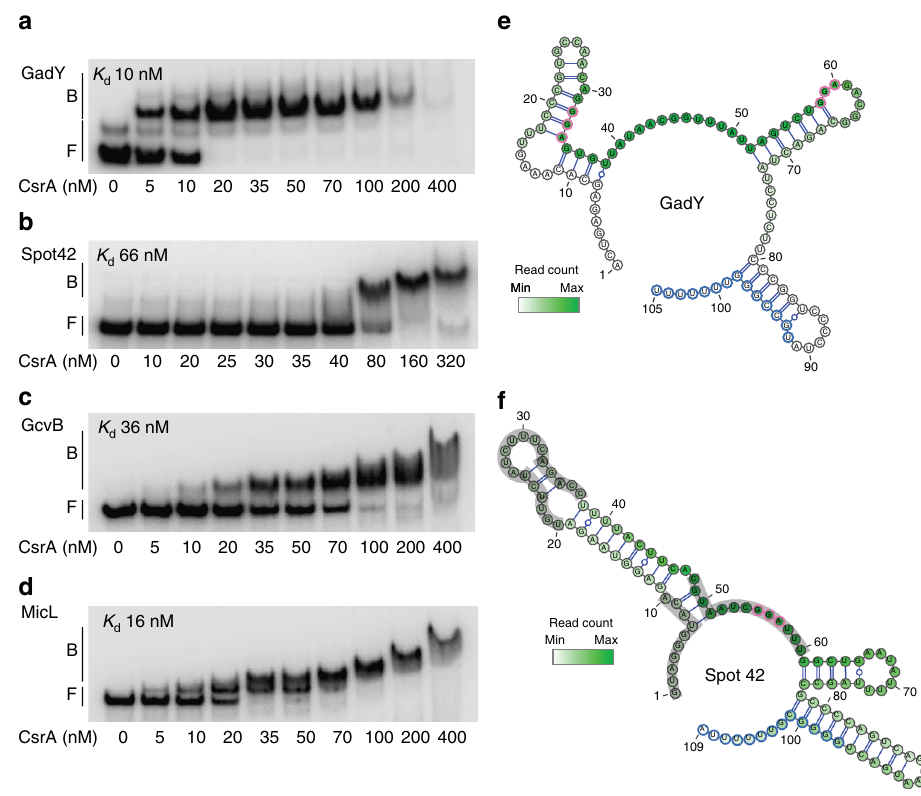
Fig. 8 CsrA binds to Hfq-dependent basepairing sRNAs. a – d Electrophoretic mobility shift assays (EMSA) for the interaction of CsrA with sRNAs. a GadY. b Spot 42. c GcvB. d MicL. e mFold 80 predicted GadY structure and f Spot 42 structure 55 with CLIP-seq reads from all fi ve replicates overlaid in green. Putative Hfq binding sites outlined in blue were predicted using the consensus Hfq binding motif identi fi ed in Salmonella 10 . GGA motifs are circled in pink. Regions involved in Spot 42 basepairing with mRNA targets are outlined in gray